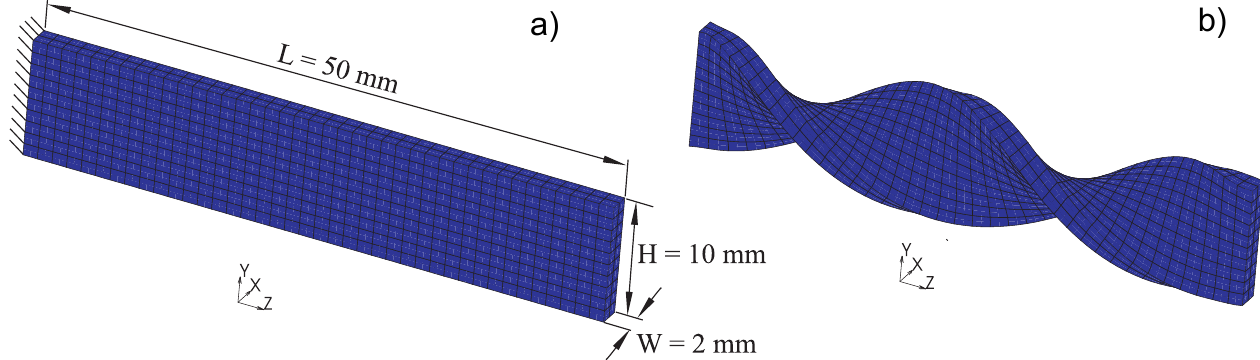
Figure 13. ( a ): Geometry of the beam sample and the Finite Element Method (FEM) mesh in its initial (undeformed) configuration and ( b ): The shape of the sample twisted up to 360 ◦ at t = 300 s.